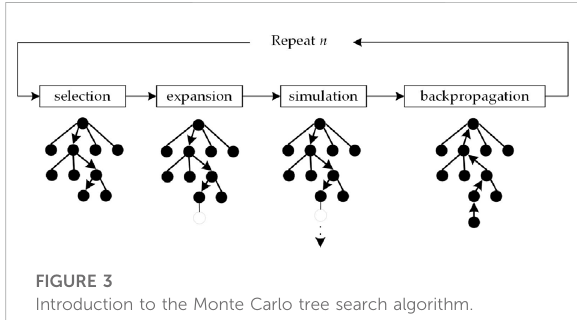
FIGURE 3 Introduction to the Monte Carlo tree search